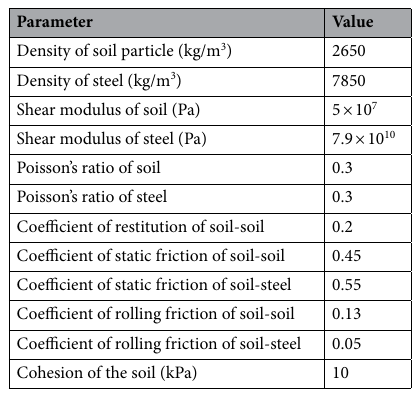
Table 2. Basic parameters of the discrete element model.